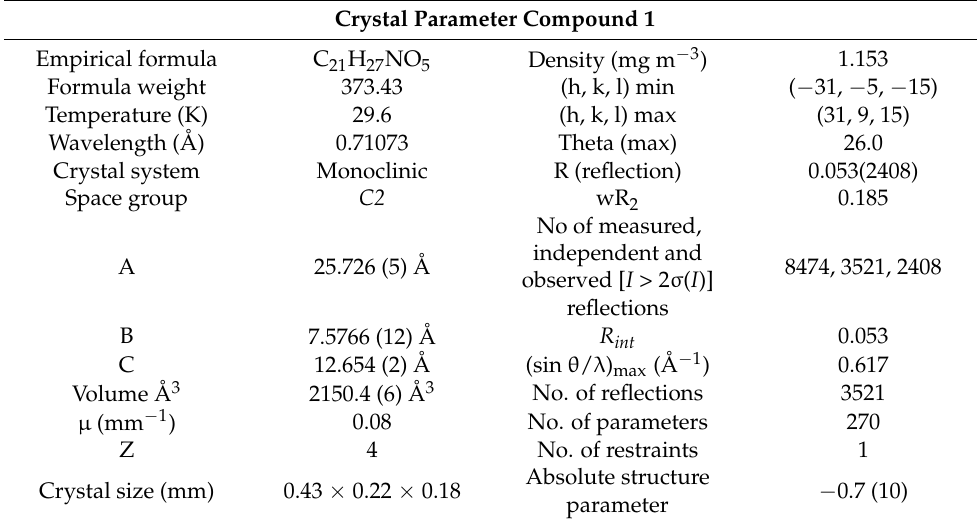
Table 2. Crystal data and structure refinement of Compound 1.